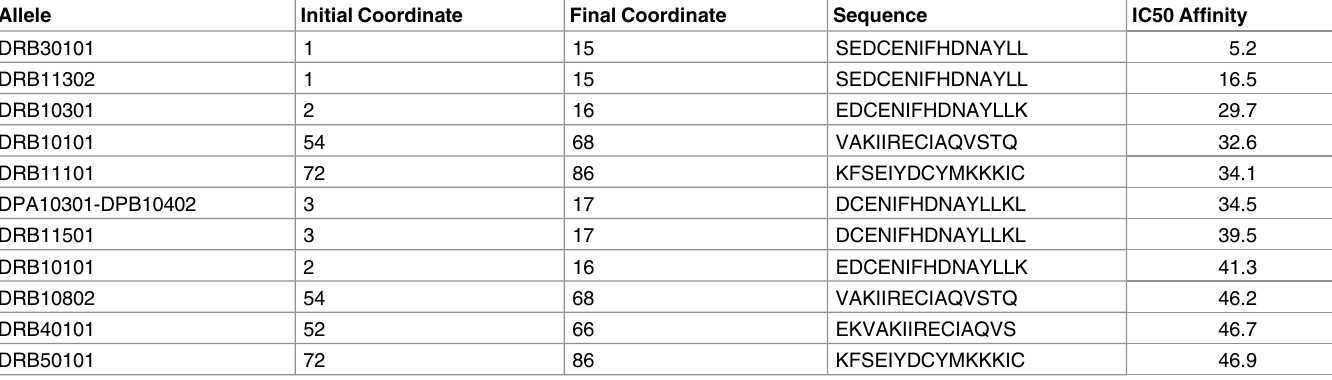
Table 2. Predicted MHC class II T cell epitopes for the SALO protein in humans. Allele Initial Coordinate Final Coordinate Sequence IC50